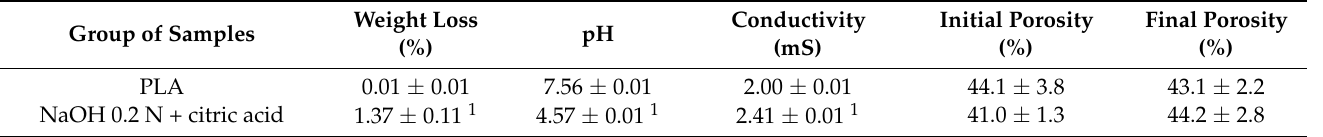
Table 1. Results of the one-day enzymatic degradation